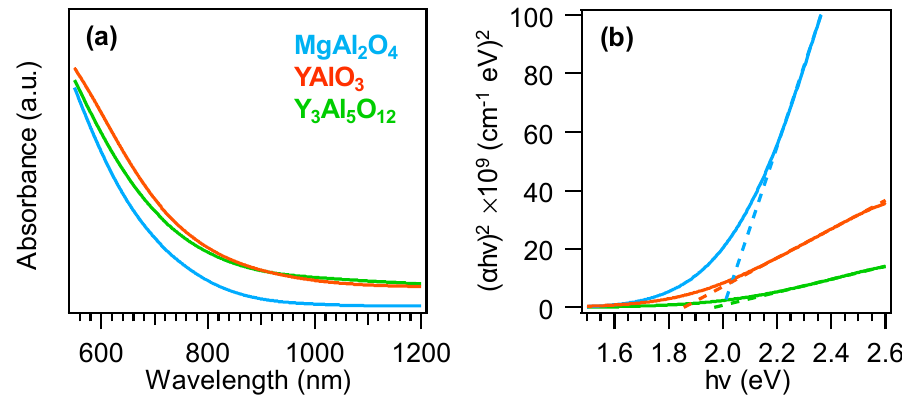
Figure 5. ( a ) Optical absorption spectra of MnO 2 nanomaterials grown on different substrates and ( b ) corresponding Tauc plots.